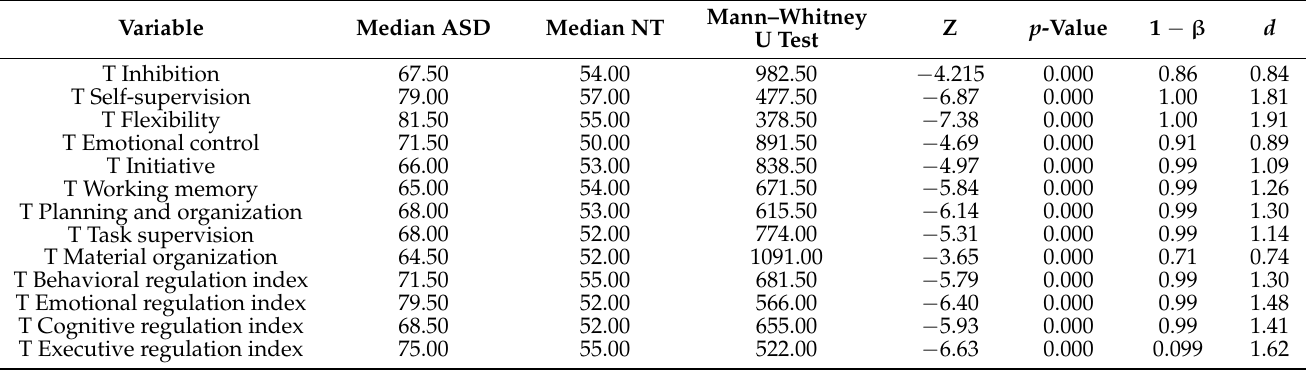
Table 2. Comparison between groups in continuous variables. U de